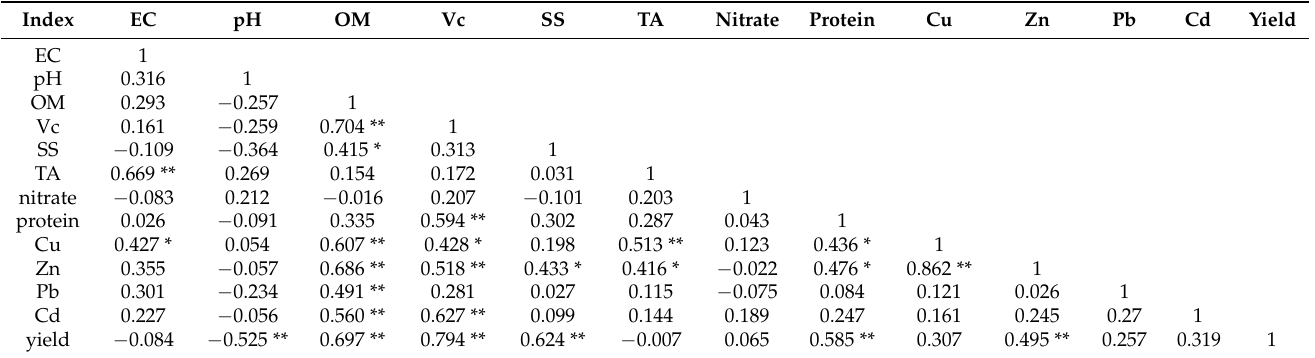
Table 9. Correlation analysis between soil properties, cucumber yield, and